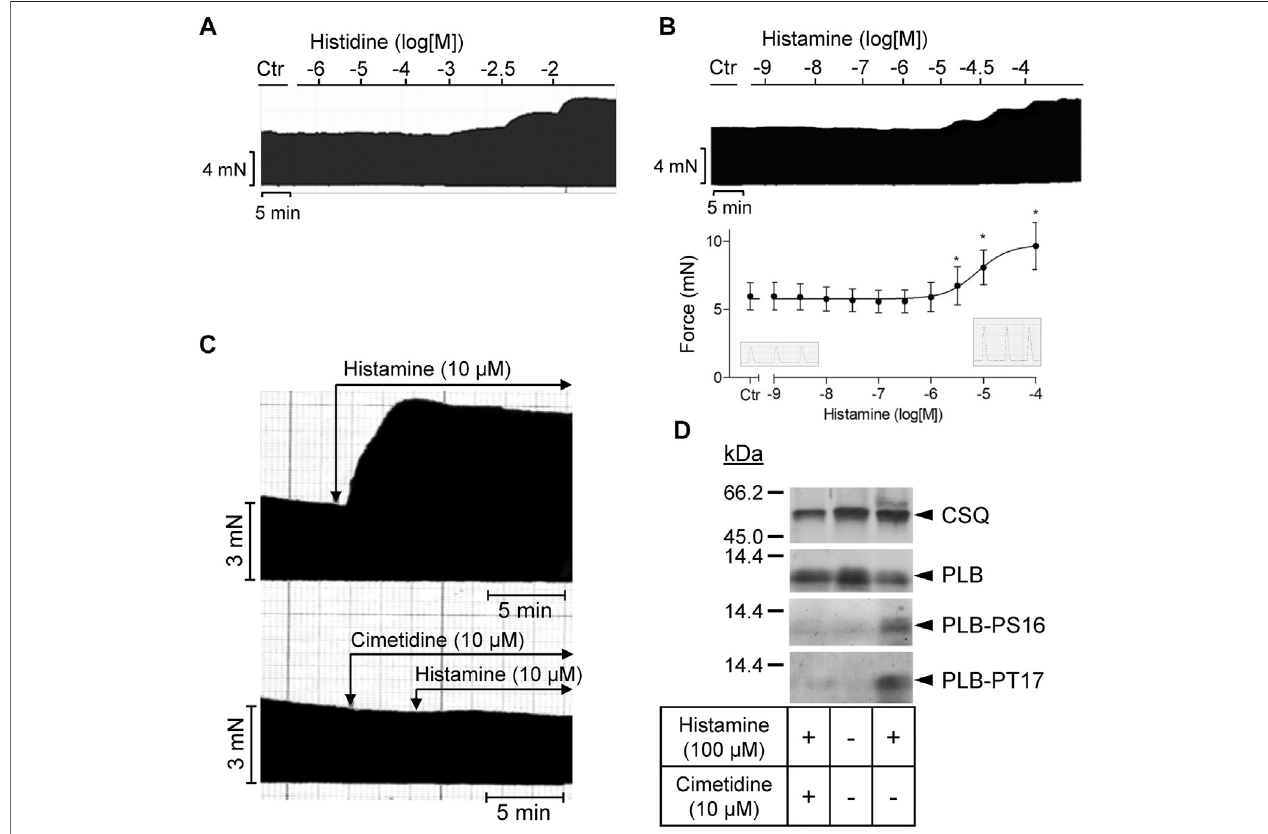
FIGURE 3 | Human right atrial preparations. (A) Representative original recording of the concentration- and time-dependent effect of histidine on the force of contraction(FOC)inisolatedelectricallydriven(1 Hz)atrialpreparationsfromhumanheart.Forcomparison,theeffectofhistidineontheFOCinisolatedelectricallydriven left atrial preparation from H 2 -TG mouse heart is shown as Supplementary Figure S1 . (B) Representative original recording and quanti fi cation (n (cid:2) 9) of the concentration- and time-dependent effect of histamine on the FOC in isolated electrically driven (1 Hz) atrial preparations from human heart. * p < 0.05 vs. Ctr. (C) Effectof10 µMhistaminealoneor10 µMhistamineinthepresenceof10 µMcimetidineonFOCinisolatedelectricallydriven(1 Hz)atrialpreparationsfromhumanheart: original recordings. (D) Representative original Western blots indicating an increase of phospholamban (PLB) phosphorylation at serine 16 (PS16) and at threonine 17 (PT17) under histamine. The PLB phosphorylation was cimetidine-sensitive. Calsequestrin (CSQ) expression was used as loading control. Molecular weight markers in kilo Dalton (kDa) are indicated. Samples used were frozen from contraction studies like those in (C) .